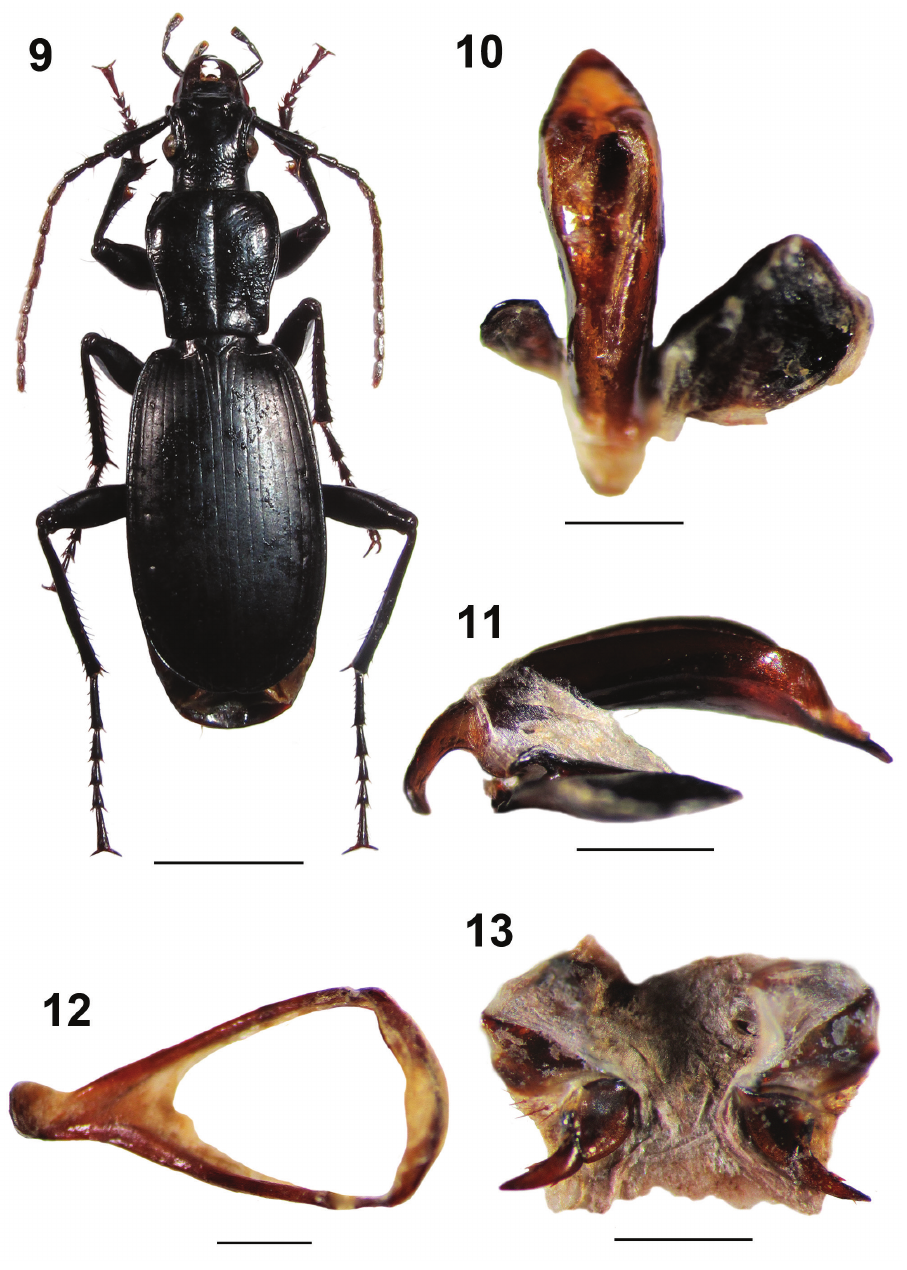
Figures 9–13. Omphreus ( Omphreus ) morio durmitorensis ssp. n. from northwestern Montenegro, Mt. Durmitor, Sedlo pass, 2,100–2,200 m a.s.l., near Žabljak. 9 holotype male, habitus (dorsal view) 10 holo- type male, aedeagus (dorsal view) 11 holotype male, aedeagus (lateral view) 12 holotype male, abdominal sternite IX (urite) 13 paratype female, genitalia. Scale bars 5 mm ( 9 ) and 1 mm ( 10–13